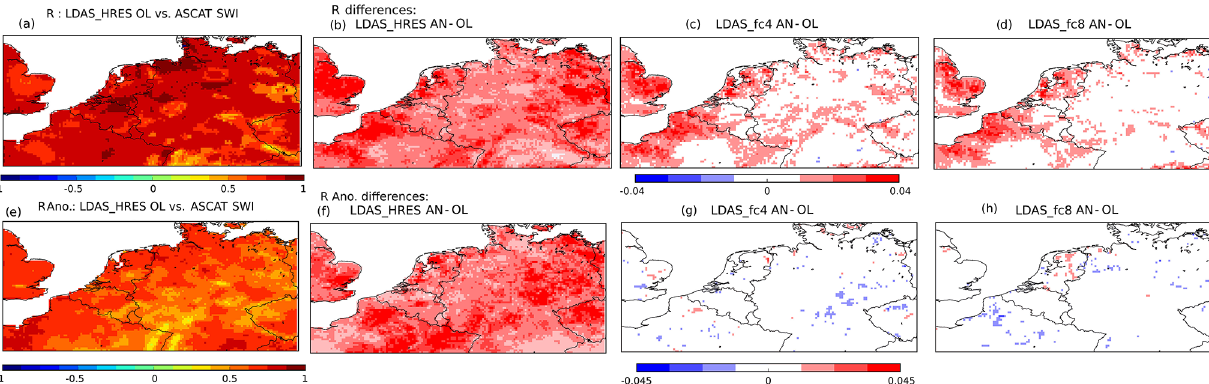
lutions, data assimilation or parameterizations). The